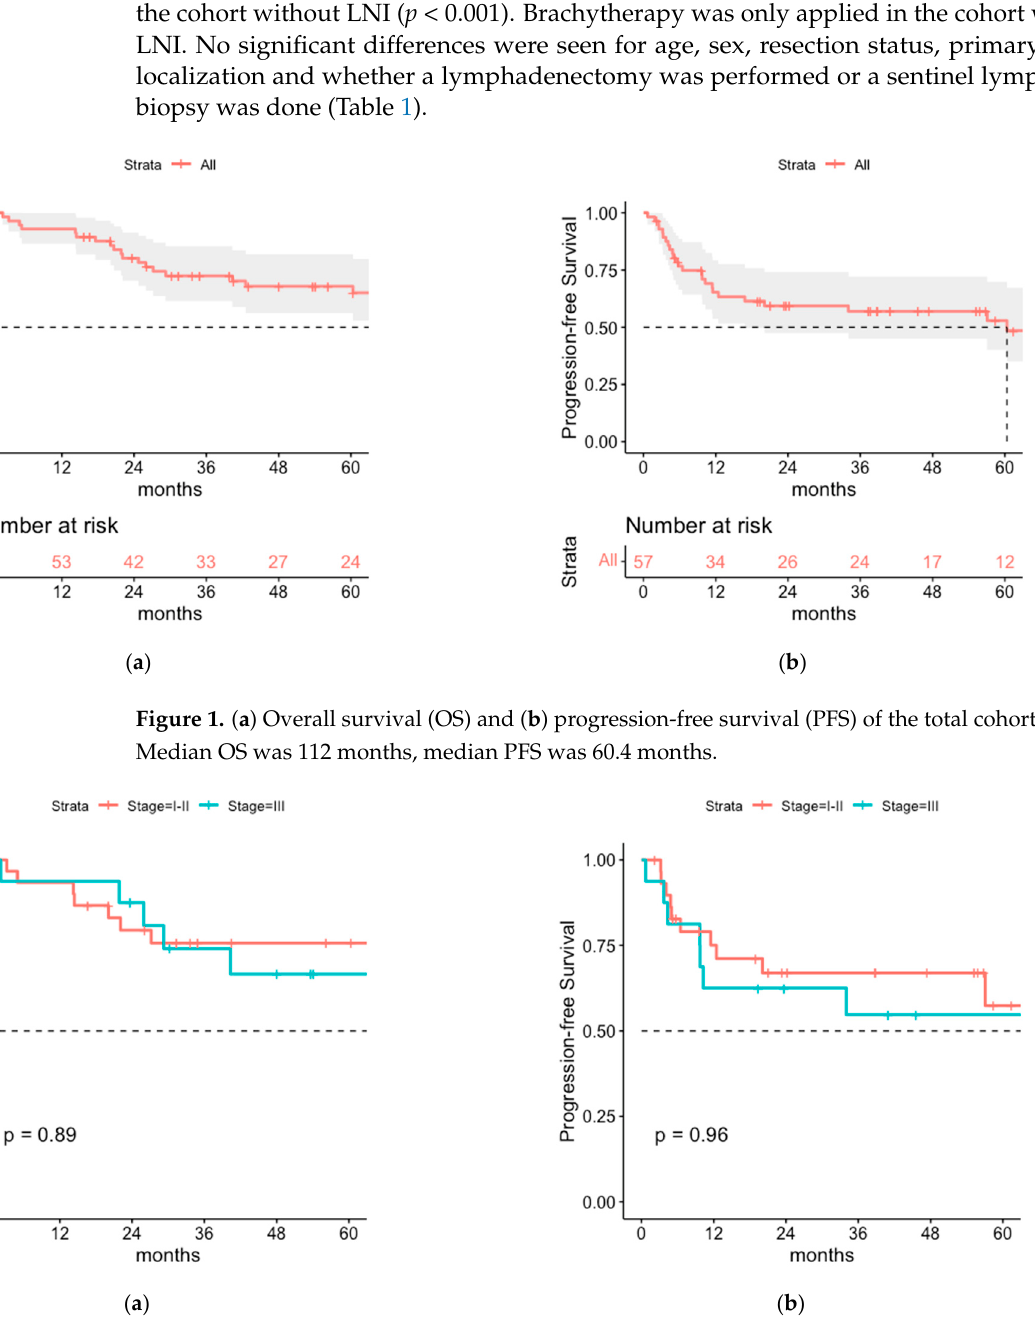
Figure 2. ( a ) Stage-adapted overall survival and ( b ) stage-adapted progression-free survival of surgically staged patients (n = 46).